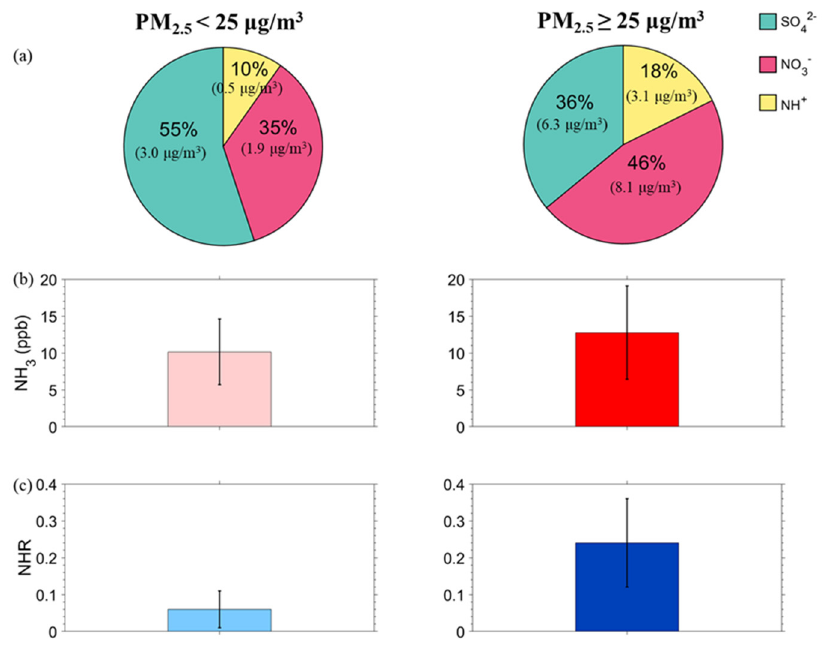
Figure 5. Comparisons of ( a ) SO 42 − , NO 3 − , and NH 4+ of PM 2.5 , ( b ) NH 3 concentrations, and ( c ) the ratio of NH 4+ to total NH 3 (NHR) on clean (PM 2.5 < 25 μ g/m 3 ) versus polluted (PM 2.5 ≥ 25 μ g/m 3 ) days.